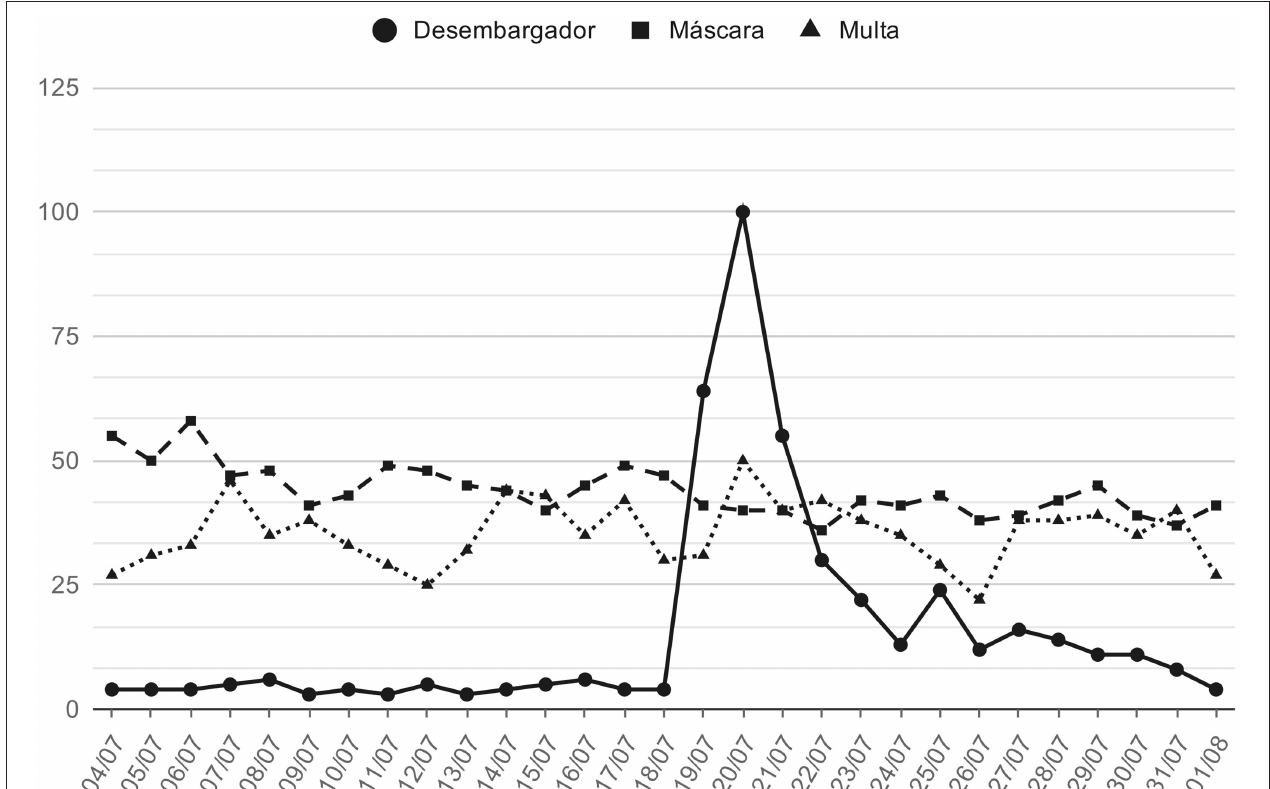
FIGURE 7 | Web Search for “Judge,” “Mask,” and “Fee” between 7/4/20 and 8/1/20. https://trends.google.com/trends/explore?date=2020-06-10%202020-07-31& geo=BR&q=Desembargador,M%C3%A1scara.